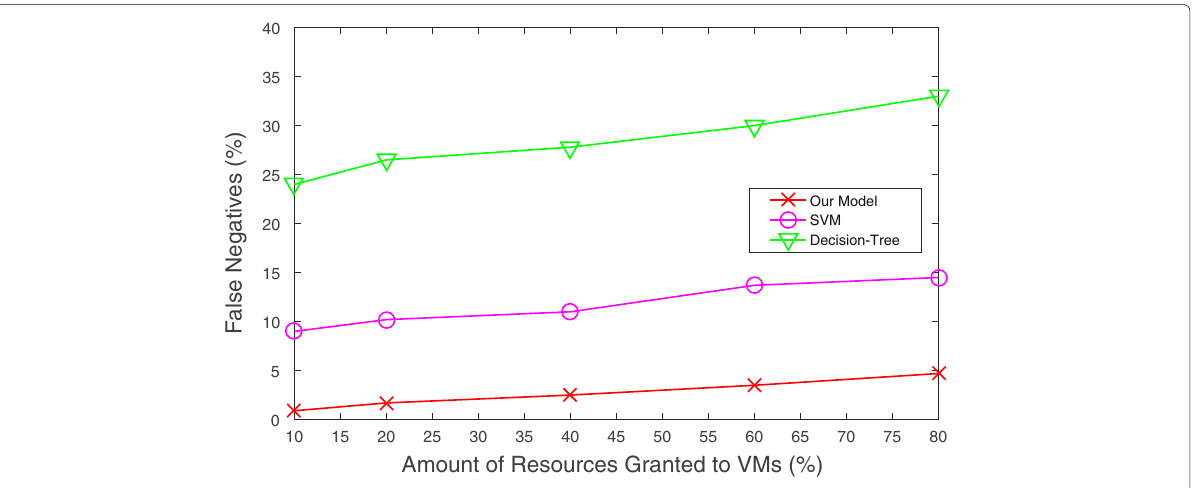
Fig. 11 False negative percentage w.r.t. amount of granted resources